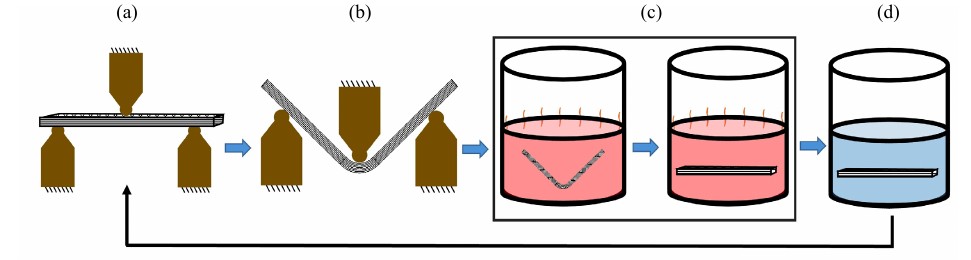
Figure 2. The sequence of the steps involved in a flexural test performed for multiple cycles: ( a ) Un- deformed or initial position of the 4D-printed flexural specimen; ( b ) deformed flexural specimen;